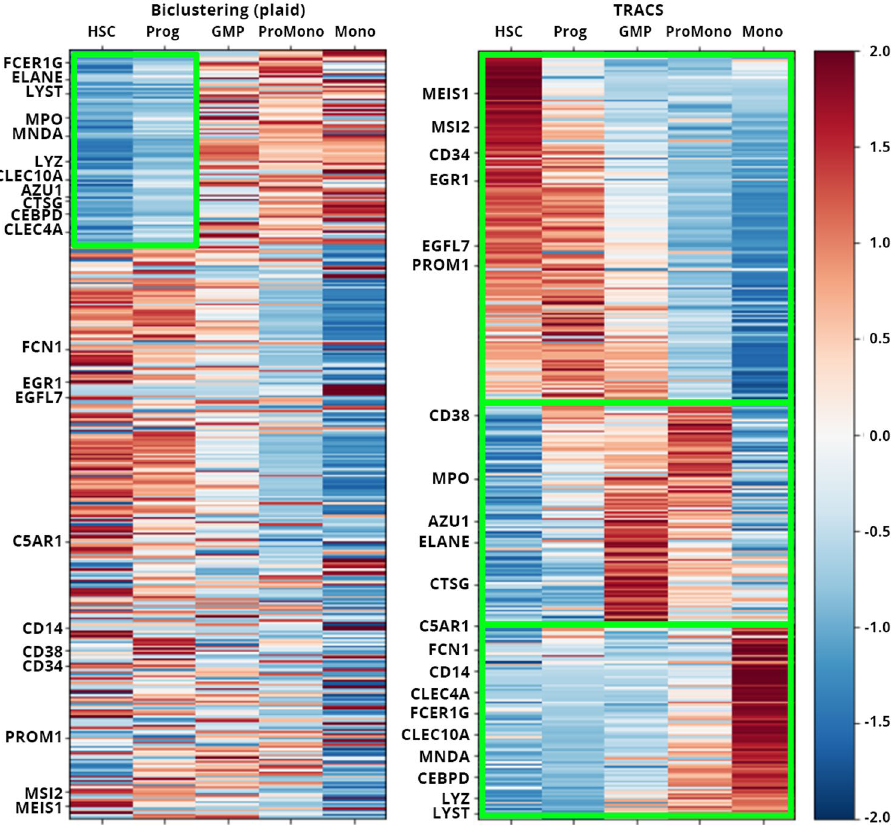
Figure 5. Heatmap of the clustering results of scRNA-seq data by plaid model biclustering algorithm (left) and TRACS (right). Detected clusters are marked as green boxes. 21 cell-type-specific genes that represent successive stages of hematopoietic development are specified on the left side of the heatmaps.